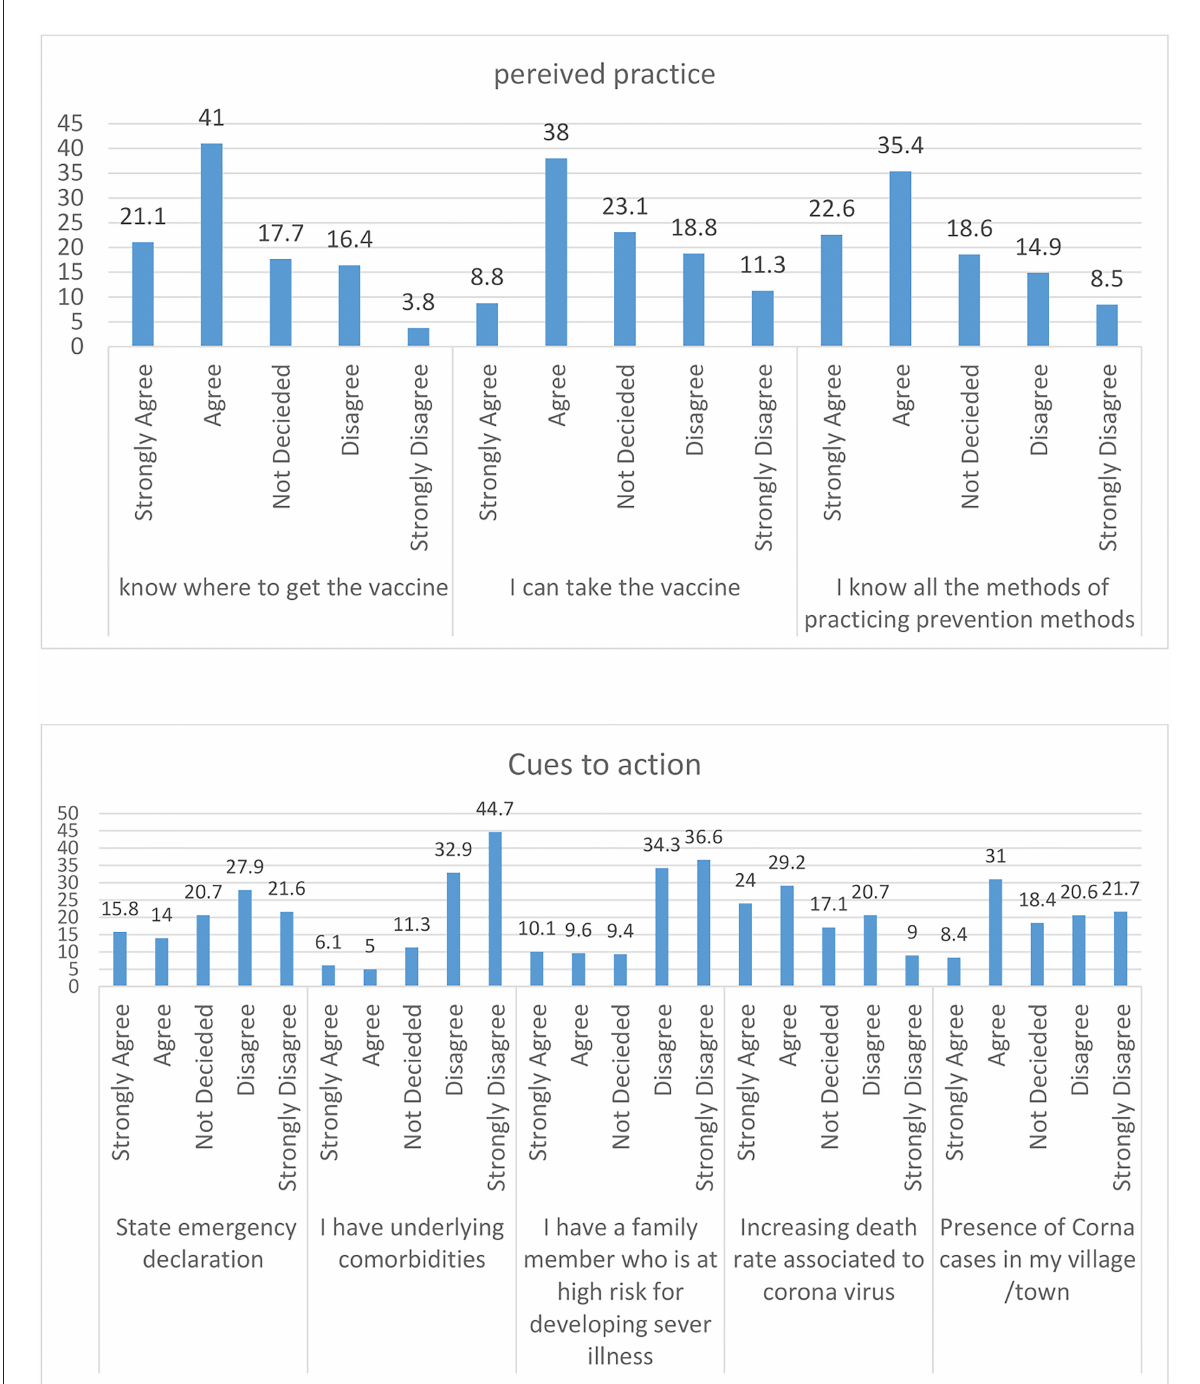
FIGURE3 Percentage of practice and cues to action attitude toward COVID-19 of the study participants.